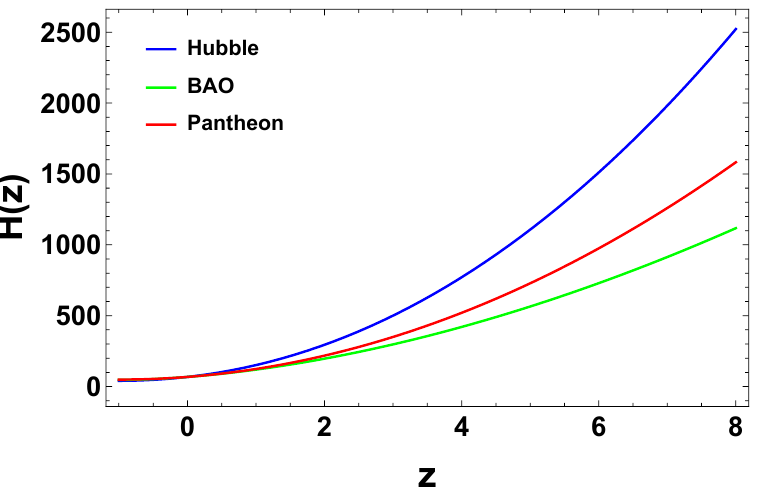
Figure 5. Profile of the Hubble parameter for the given model corresponding to the values of the parameters constrained by the Hubble, BAO, and Pantheon data point sets.